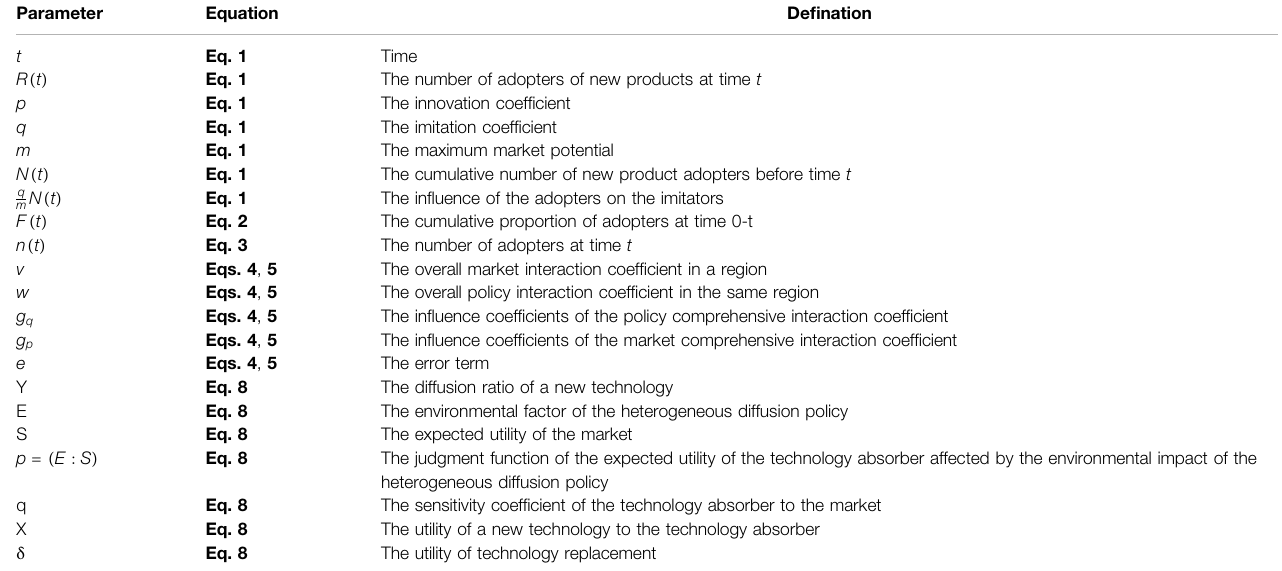
Figure 2 indicates that the difference between the actual utility of innovators and the expected utility of imitators exerts a signi fi cant impact on the peak number of imitators and the time to reach the peak. When v (cid:2) 0.5, w (cid:2) 0, see Figure 2A , the growth rate of imitator enterprises is slowest, and the peak value of imitator enterprises is lowest. This shows that because of the imperfect policy environment, the actual utility of innovator enterprises is low. Consequently, imitator enterprises cannot obtain favorable information to adopt technology, and thus, the expected utility of imitator enterprises for leading technology is also low. This hinders the diffusion of leading technology in the new energy industry. When v (cid:2) 0, w (cid:2) 0.5, see Figure 2B , the growth rate of imitator